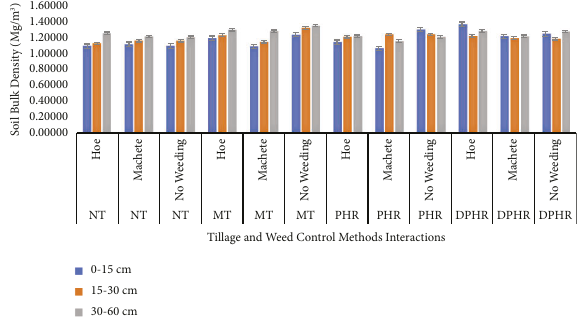
Figure 4: Tillage and weed control methods’ interaction effect on soil dry bulk density.